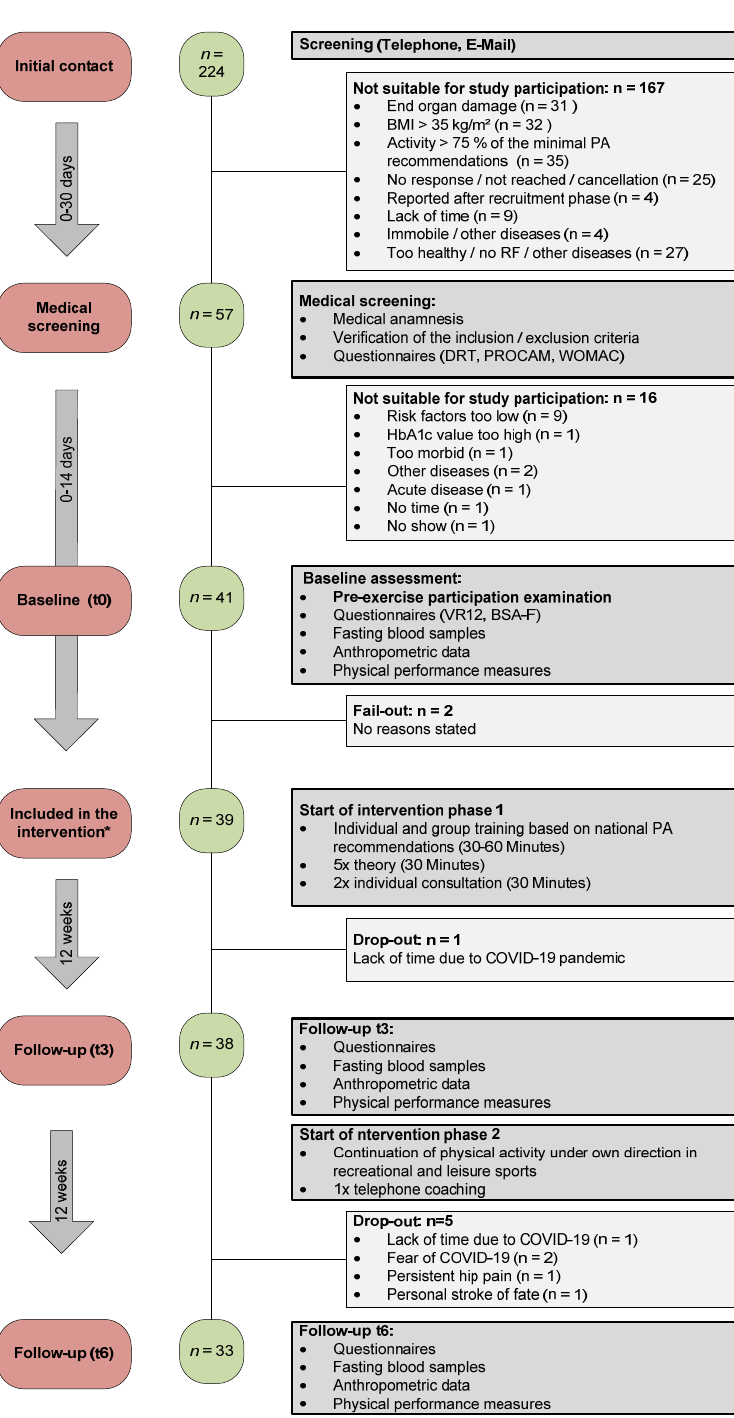
Figure 3. Study Flow Chart of the MultiPill-Exercise intervention summarizing the total